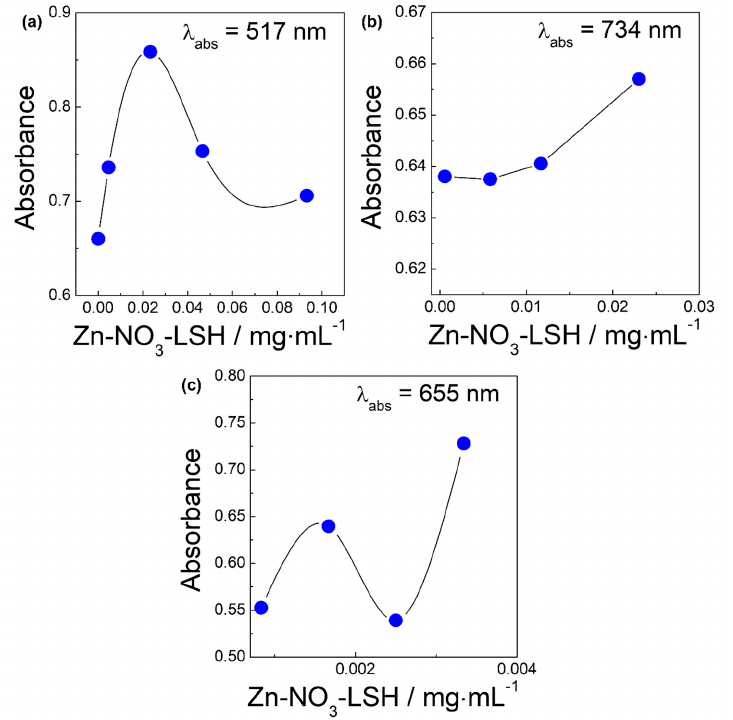
Figure A6. Average absorbance of ( a ) DPPH • and ( b )ABTS •+ reactive species as function of Zn-NO 3 -LSH concentration in the DPPH • and ABTS •+ assay, respectively. Average absorbance of the ( c ) TMB chromophore in presence of HOCl/OCl − species as function of host matrix concentration.